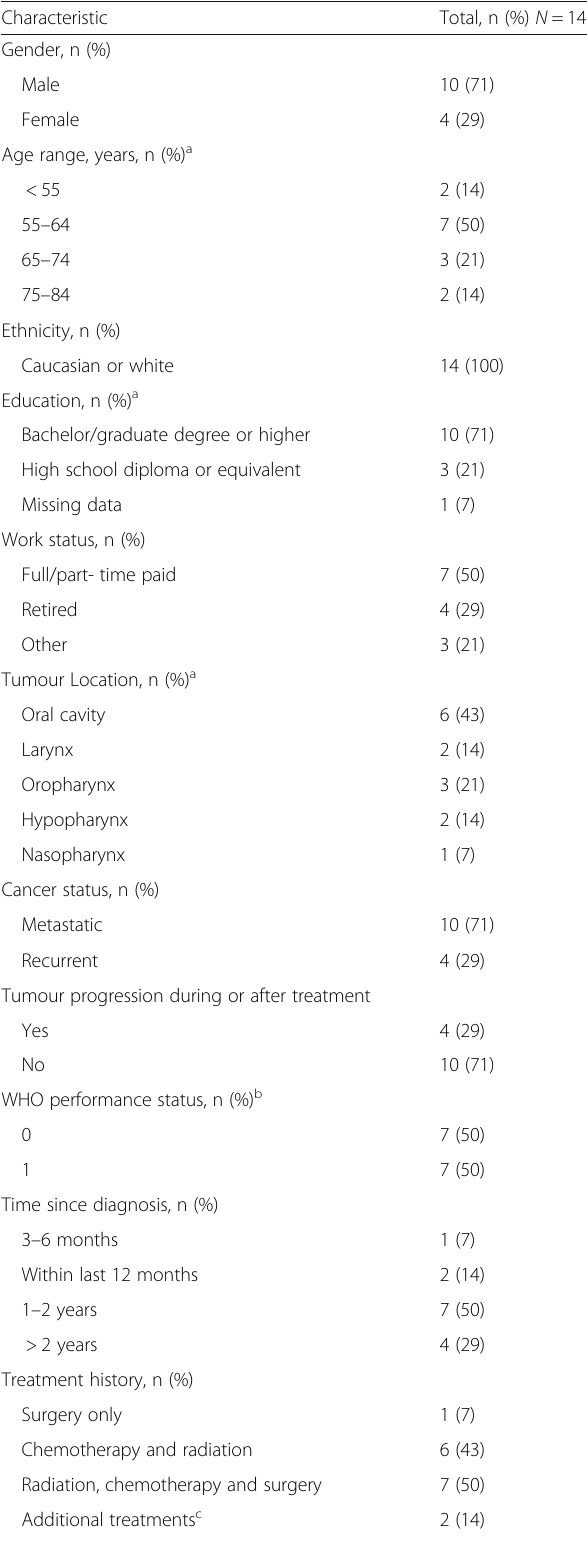
Table 2 Demographic and clinical characteristics of interviewed